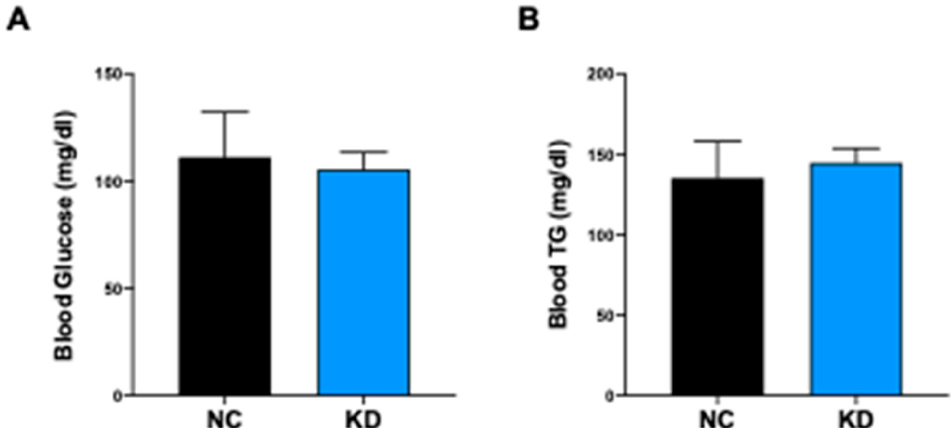
Figure 6. Ketogenic diet effect on blood levels of glucose and triglycerides. ( A ) Bar plot showing serum fasting glucose concentration (mg/dL) from mice under NC (n = 8) and KD (n = 10) at the end of dietary treatment. ( B ) Bar plot showing triglycerides (TG) serum concentration (mg/dL) from mice under NC (n = 8) and KD (n = 10) at the end of dietary treatment. Data are expressed as mean ± SEM.